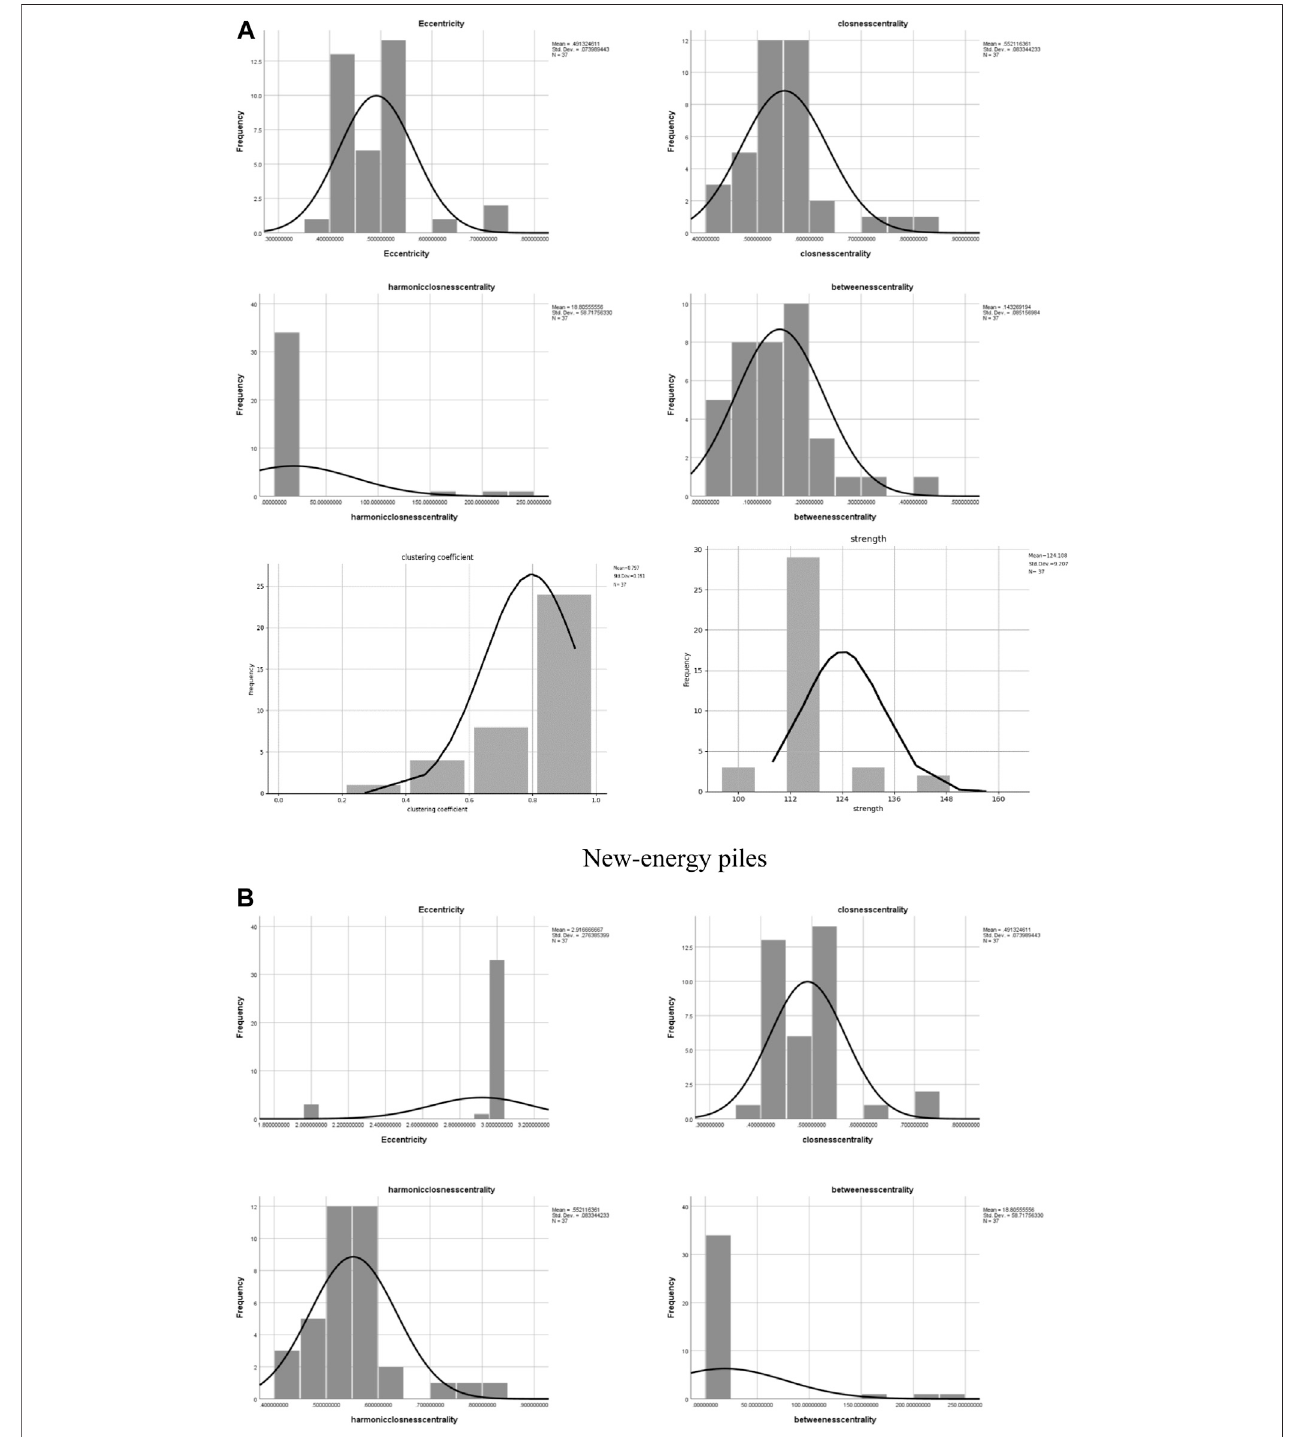
FIGURE 4 | Histogram of the frequency distribution of the centrality of (A) new-energy piles, (B) all charging piles, and (C) public charging piles. One presents the eccentricity, 2 presents the closeness centrality, 3 presents the harmonic closeness centrality, four presents the betweenness centrality, 5 presents the clustering coef fi cient, and 6 presents the strength.